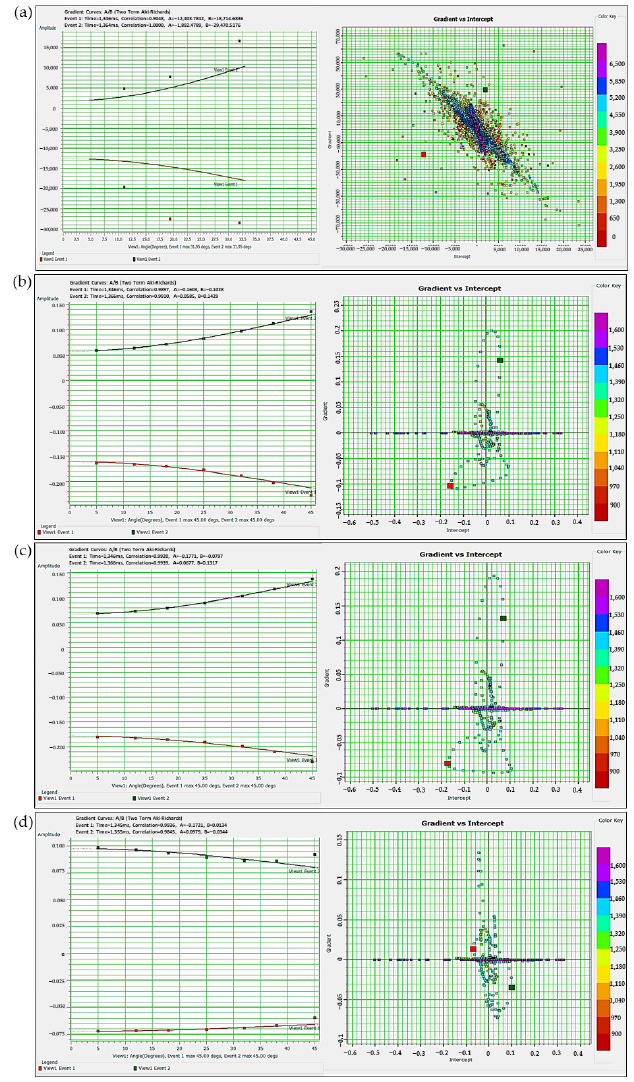
Figure 11. AVO analysis from some models, ( a ) original seismic, ( b ) in situ, ( c ) pure gas, and ( d ) pure brine.